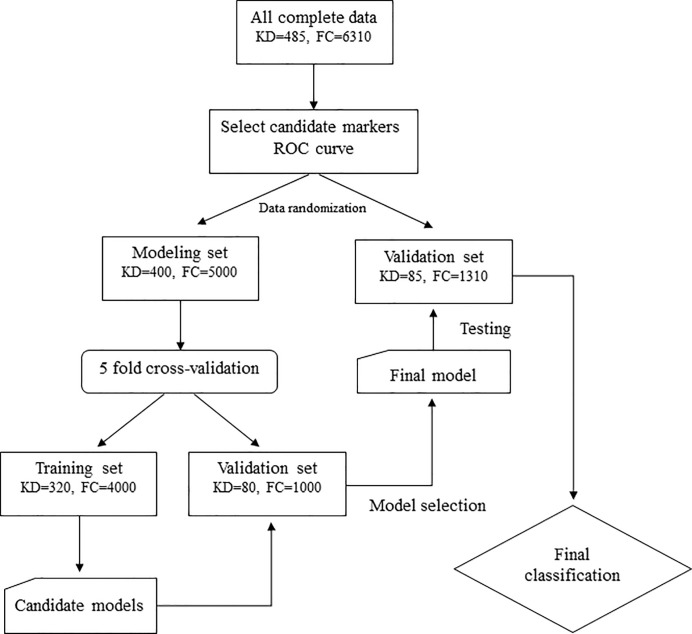
Flow chart of this study.KD: Kawasaki disease, FC: febrile children.